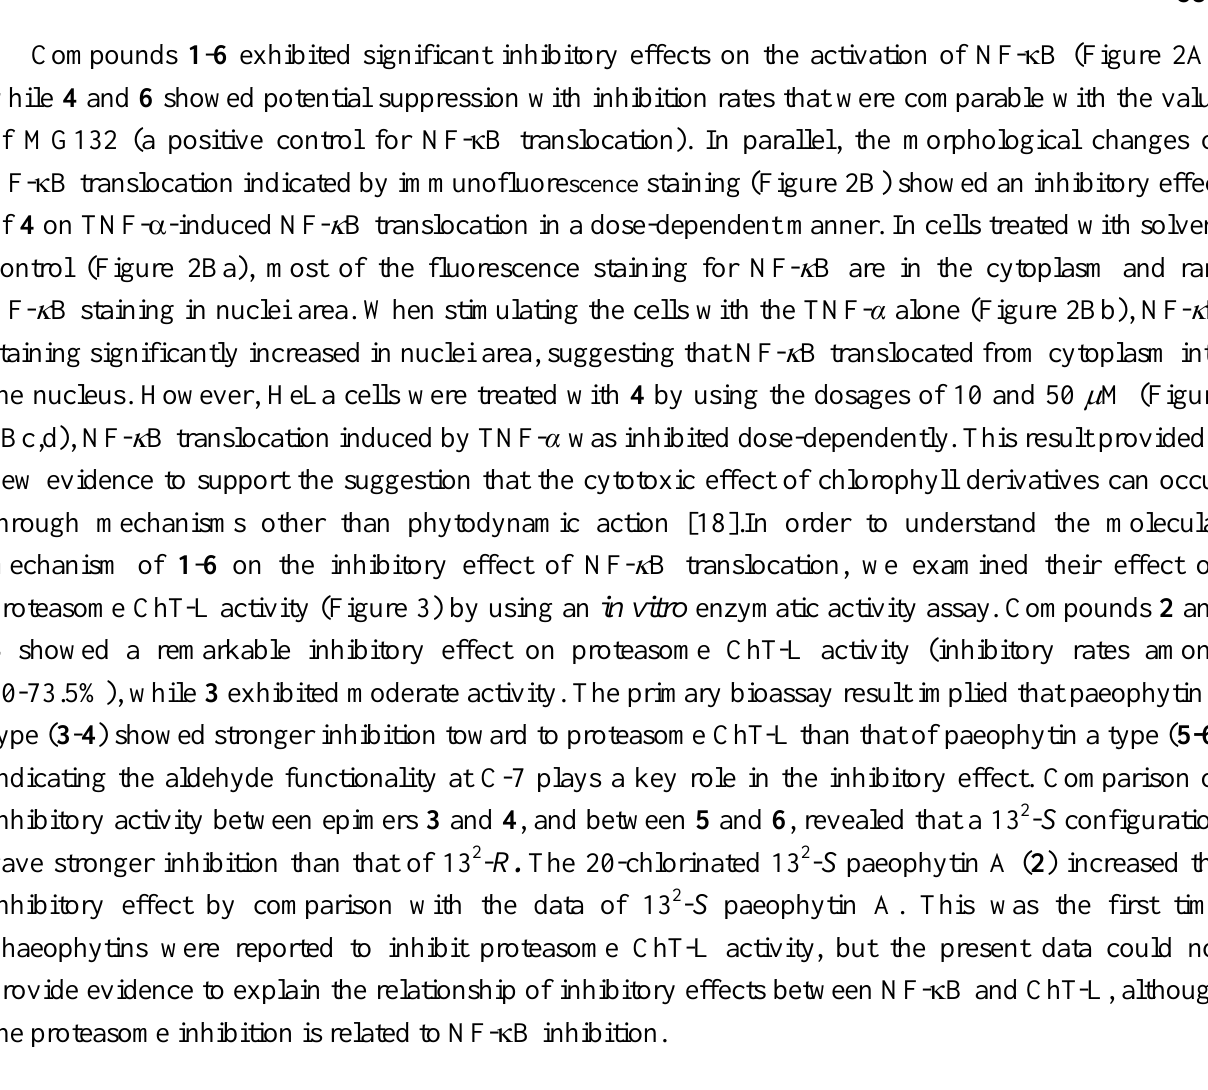
Figure 3 . Effect of 1 - 6 on 20 S proteasome ChT-L activity. 20 S proteasome was incubated with compounds 1 - 6 (50 µ M of each) and fluorogenic peptide (100 µ M) in 100 µ L of 20 mM Tris-HCl (pH 7.8), at 37 ºC for 1 hour. The proteasome ChT-L activity was assayed after addition of specific substrate. MG132 (1.0 µ M) was used as a positive control. Data were measured by means of ± SD from three independent